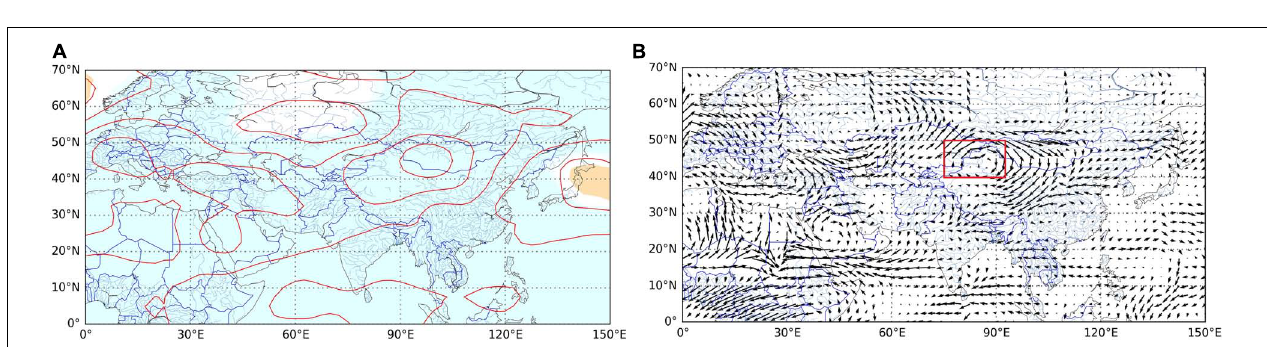
FIGURE 7 | Correlation coefficients (shown in color shading) between atmospheric circulation and extreme climate indices for 1961–2017: (A) extreme precipitation and (B) extreme temperature (cell numbers are p -values).